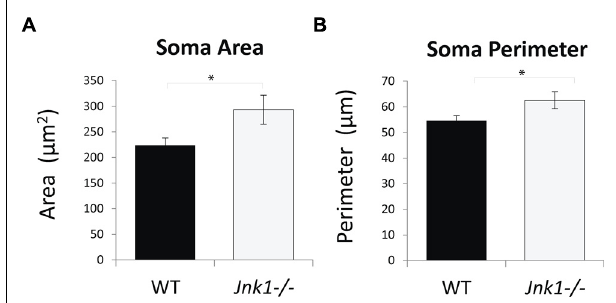
FIGURE 5 | Cell soma size is increased in M1 pyramidal neurons of Jnk1-/- mice. (A,B) Cell soma areas and perimeters from Lucifer yellow-loaded neurons in L5 of M1 from wild-type and Jnk1-/- mice are shown.There was a significant increase in soma size in Jnk1-/- mice. Six wild-type and 13 Jnk1-/- cells were counted from different animals. Means ± SEMs are indicated. * p <